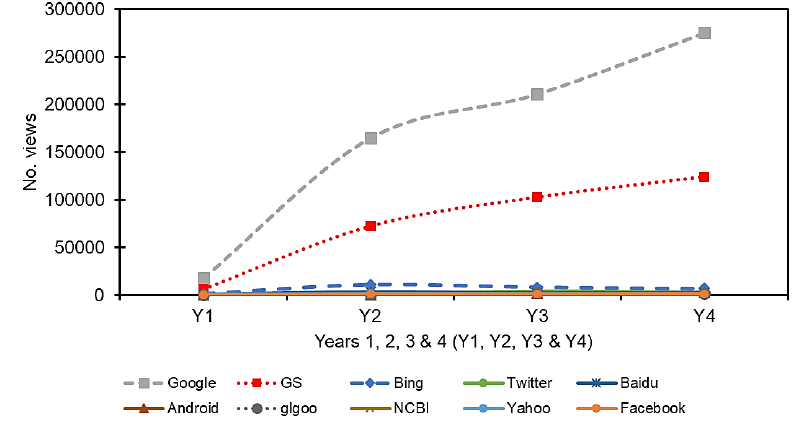
Figure 7. Top ten web traffic referral sources during Y1, Y2, Y3 and Y4. Local sources excluded.